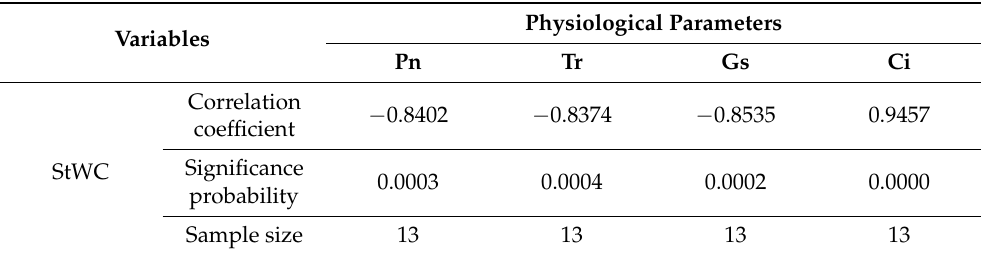
Table 4. Correlations between stem water content (StWC) and four physiological parameters of Lagerstroemia indica L. under unstressed conditions on a typical summer day.